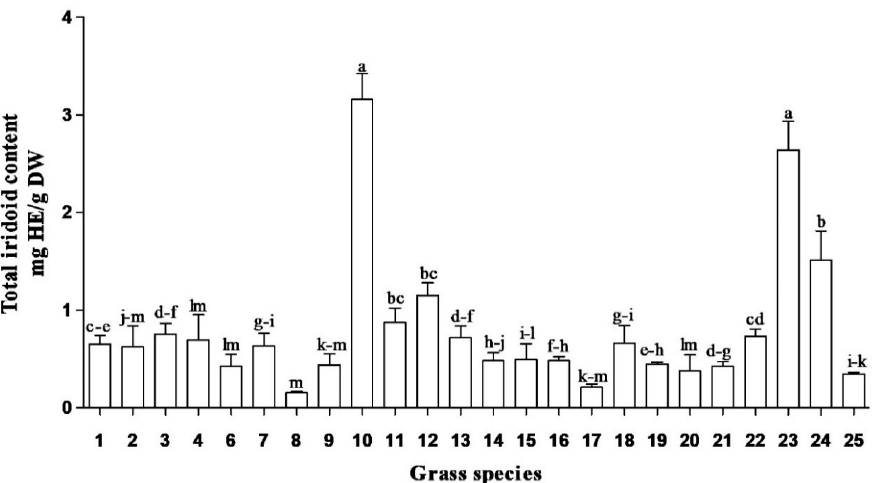
Figure 3. Total iridoid content in grass species used in South African traditional medicine. HE = harpagoside equivalents; DW = dry weight. Bar represents mean ± standard error, n = 3. Bars with different letter(s) are significantly ( p ≤ 0.05) different based on Duncan’s multiple range test (DMRT). (1) Coix lacryma-jobi Roots, (2) Coix lacryma-jobi Leaves, (3) Eragrostis curvula Roots, (4) Eragrostis curvula Leaves, (6) Setaria megaphylla Roots, (7) Setaria megaphylla Leaves, 8. Vetiveria zizanioides Roots, 9. Vetiveria zizanioides Leaves, (10) Cymbopogon nardus Roots, (11) Cymbopogon nardus Leaves, (12) Cymbopogon nardus Inflorescence, (13) Sporobolus pyramidalis Roots, (14) Sporobolus pyramidalis Leaves, (15) Sporobolus africanus Roots, (16) Sporobolus africanus Leaves, (17) Imperata cylindrical Roots, (18) Imperata cylindrical Leaves, (19) Cenchrus ciliaris Roots, (20) Cenchrus ciliaris Leaves, (21) Panicum maximum Roots, (22) Panicum maximum Leaves, (23) Cymbopogon spp. Roots, (24) Cymbopogon spp. Leaves and (25) Cynodon dactylon Whole